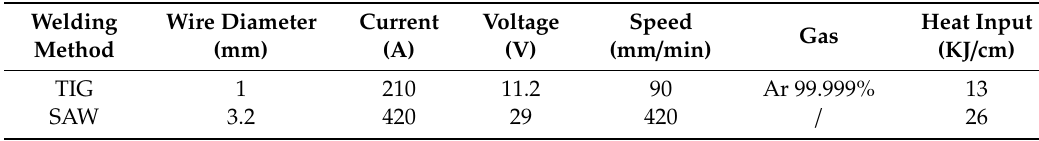
Table 2. The detailed welding process parameters.